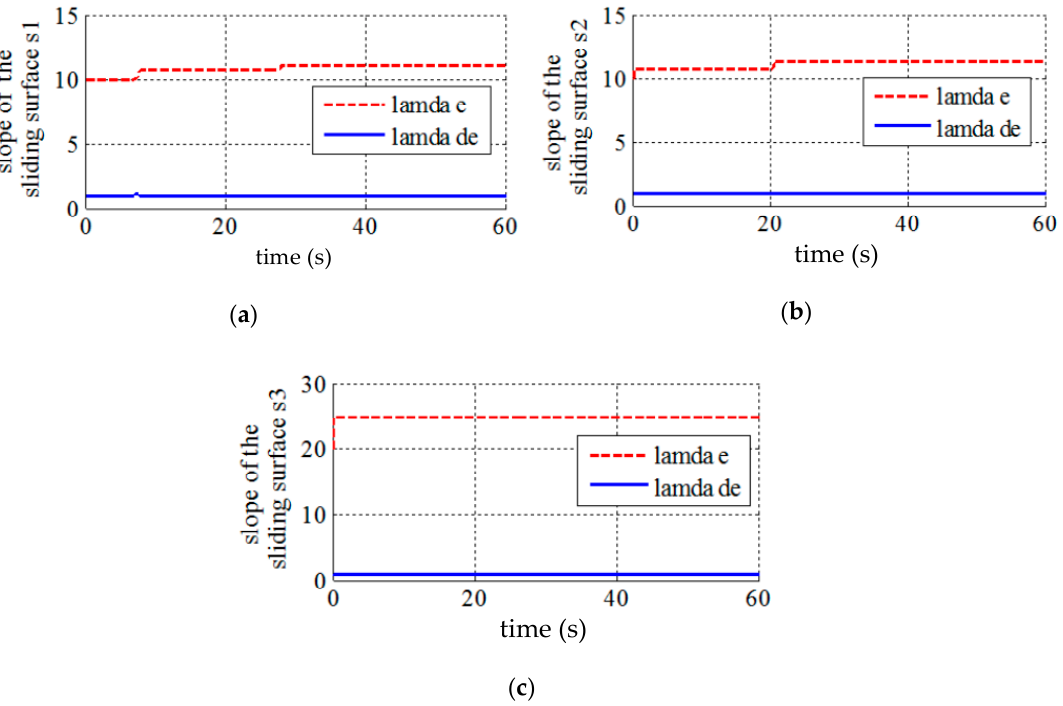
Figure 10. The slope adjusted for the sliding surface of the ( a ) first joint, ( b ) second joint, ( c ) third